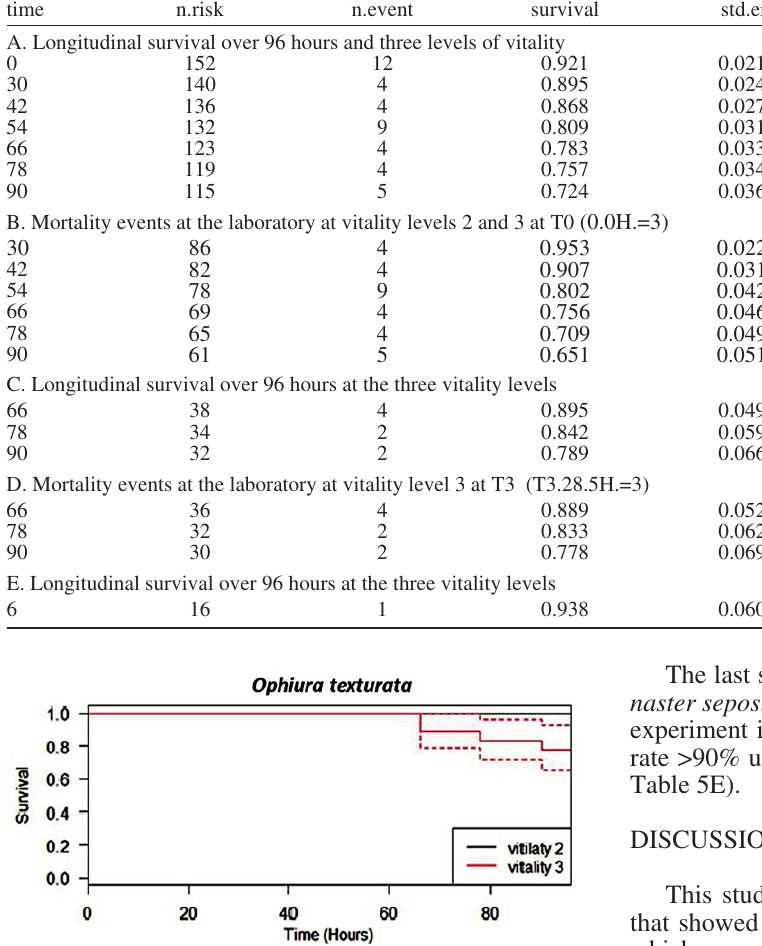
Table 5. Results of K-M model to analyse the survival of Leptometra phalangium (A and B), Ophiura texturata (C and D), Echinaster sepositus (E); n.risk, live animals; n.event, dead animals. time